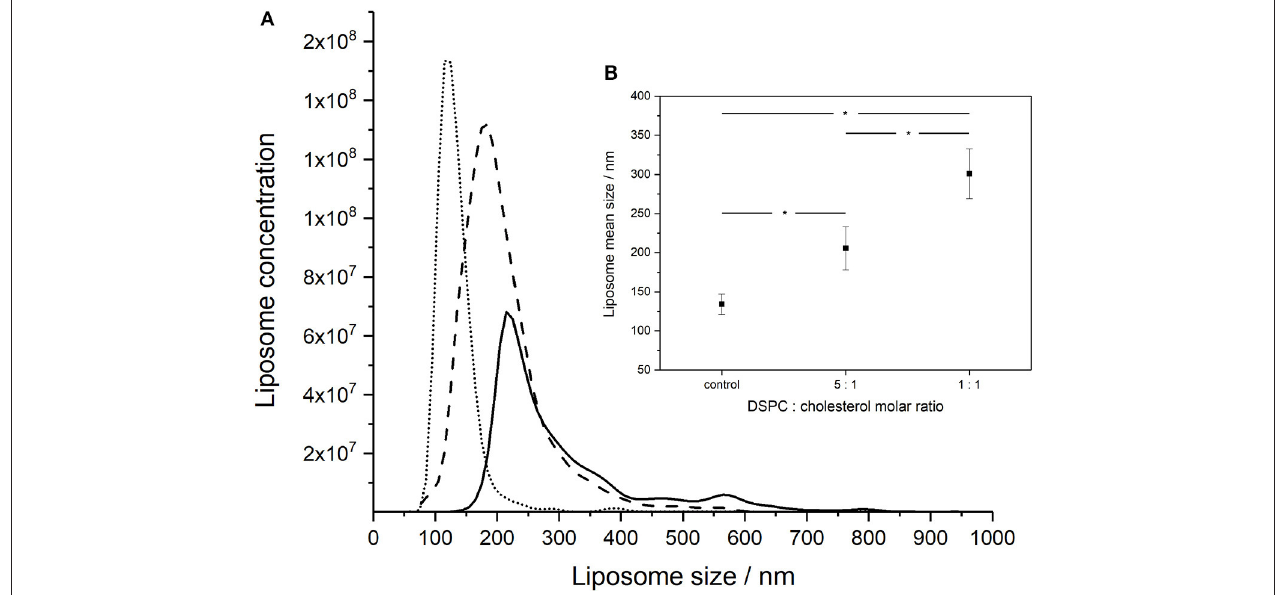
FIGURE 2 | NanoSight measurements of the size distributions of liposomes formed using different DSPC:cholesterol molar ratios: (A) DSPC only (dotted line), 5:1 DSPC:cholesterol molar ratio (dashed line), and 1:1 DSPC:cholesterol molar ratio (solid line). Liposomes were prepared at room temperature ( ∼ 20 ◦ C) using aqueous to organic phase volumetric flow rate ratio FRR of 2:1 and the total volumetric flow rate of ∼ 1ml h − 1 . (B) Inset showing average mean sizes, error bars indicate one standard deviation. *Indicates significance ( p < 0.05) using 2-sample t